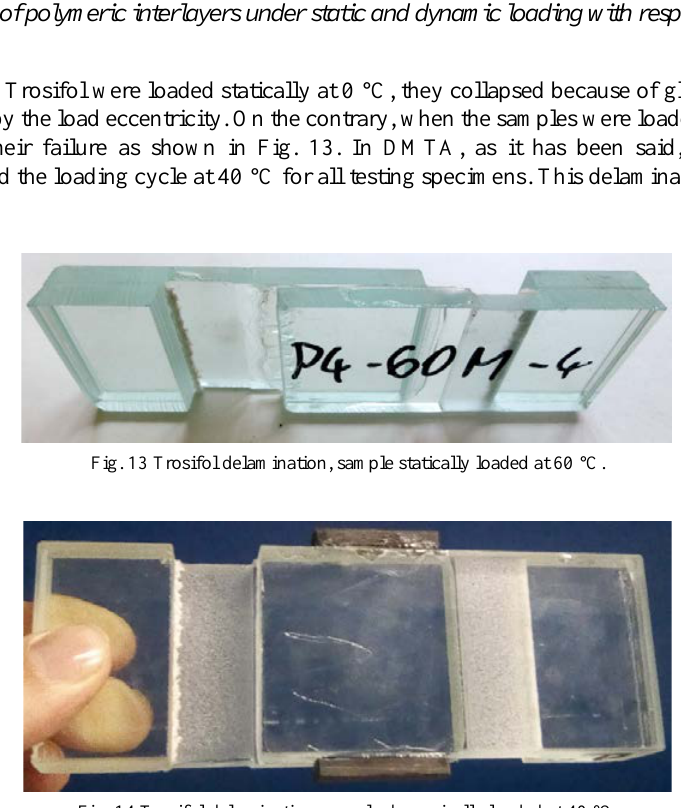
Fig. 14 Trosifol delamination, sample dynamically loaded at 40 °C.